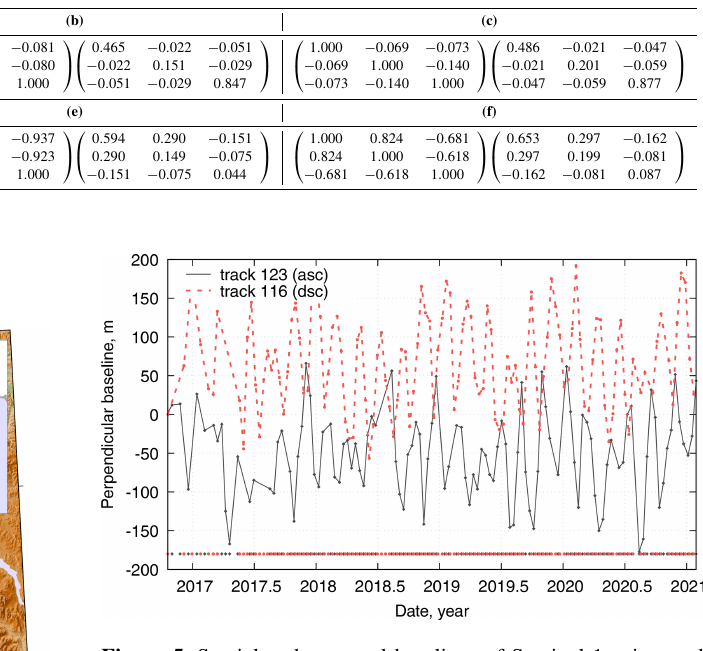
Figure 5. Spatial and temporal baselines of Sentinel-1 pairs used in this study. Mean temporal resolution, i.e., mean temporal spac- ing between consecutive SAR acquisitions regardless of orbit direc- tion, computed as duration divided by the number of SAR images (4 . 25 years × 365 / 223) is about 7d. Note that the offset between as- cending and descending sets depends on the selection of reference images, which is